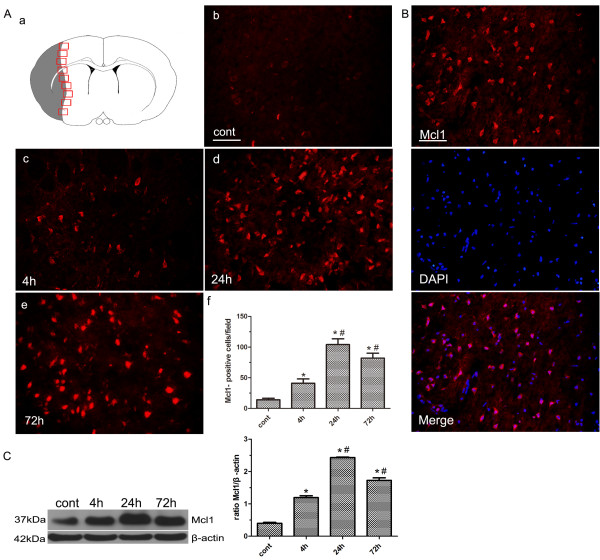
Expression of Mcl1 in brains from rats subjected to middle cerebral artery occlusion (MCAO). (A) A schematic representation of a coronal brain section. The square fields represent observed regions (a). Immunofluorescent staining showed the expression of Mcl1 in brains from sham-operated control (b) and MCAO group (4 h, 24 h, 72 h, c-e). Quantification of Mcl1-positive cells (f). Results were expressed as mean ± SD from four independent experiments. *P < 0.001 vs. control group, #P < 0.001 vs. the previous time point. Scale bars = 50 μm. (B) The co-localization of Mcl1 and DAPI indicated Mcl1was mainly localized in the cytoplasm. Scale bars = 50μm. (C) Western blot confirmed that Mcl1 protein levels were elevated in MCAO group at each time point compared with control group. Optical densities of respective protein bands were analyzed with Image J 1.42q and normalized to the loading control (β-actin). Results were expressed as mean ± SD from four independent experiments. *P < 0.001 vs. control group, #P < 0.001 vs. the previous time point.